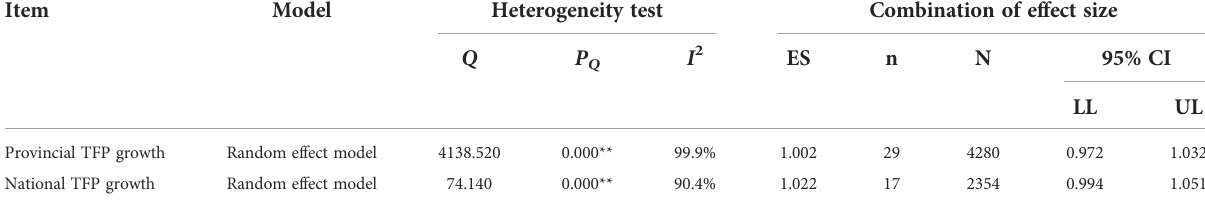
TABLE 4 Heterogeneity test and combination of effect size.